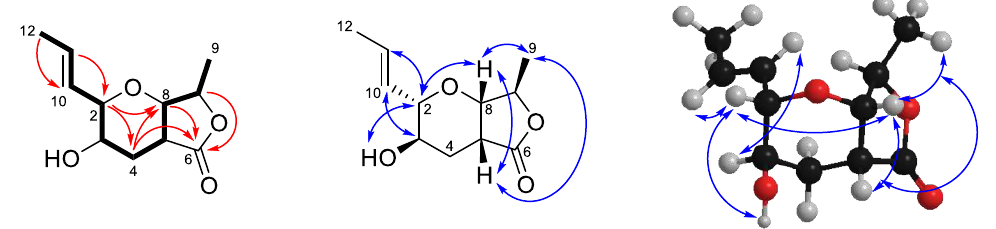
Figure 3. Selected COSY (bold), HMBC ( red arrows ) and NOESY ( blue arrows ) correlations for 1 . Comparison of the 1 H and 13 C-NMR data of 1 in CD 3 OD (Table 3, Figures S2 and S3) with